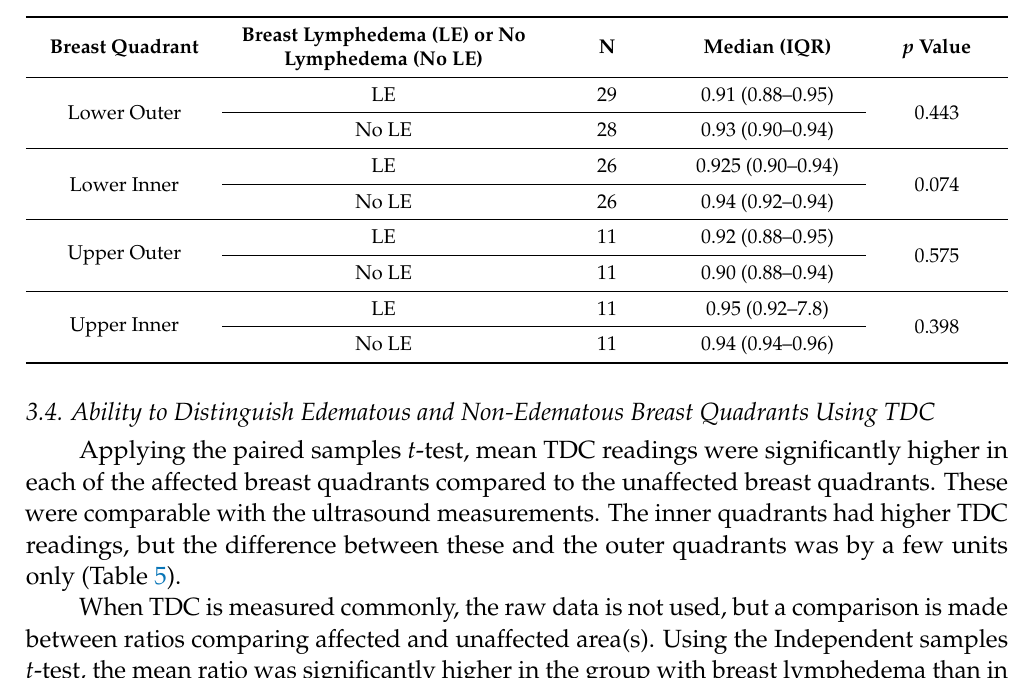
Table 4. Comparison of the Tonometer Measurements of the Individual Breast Quadrants using the Wilcoxon Signed Rank test.